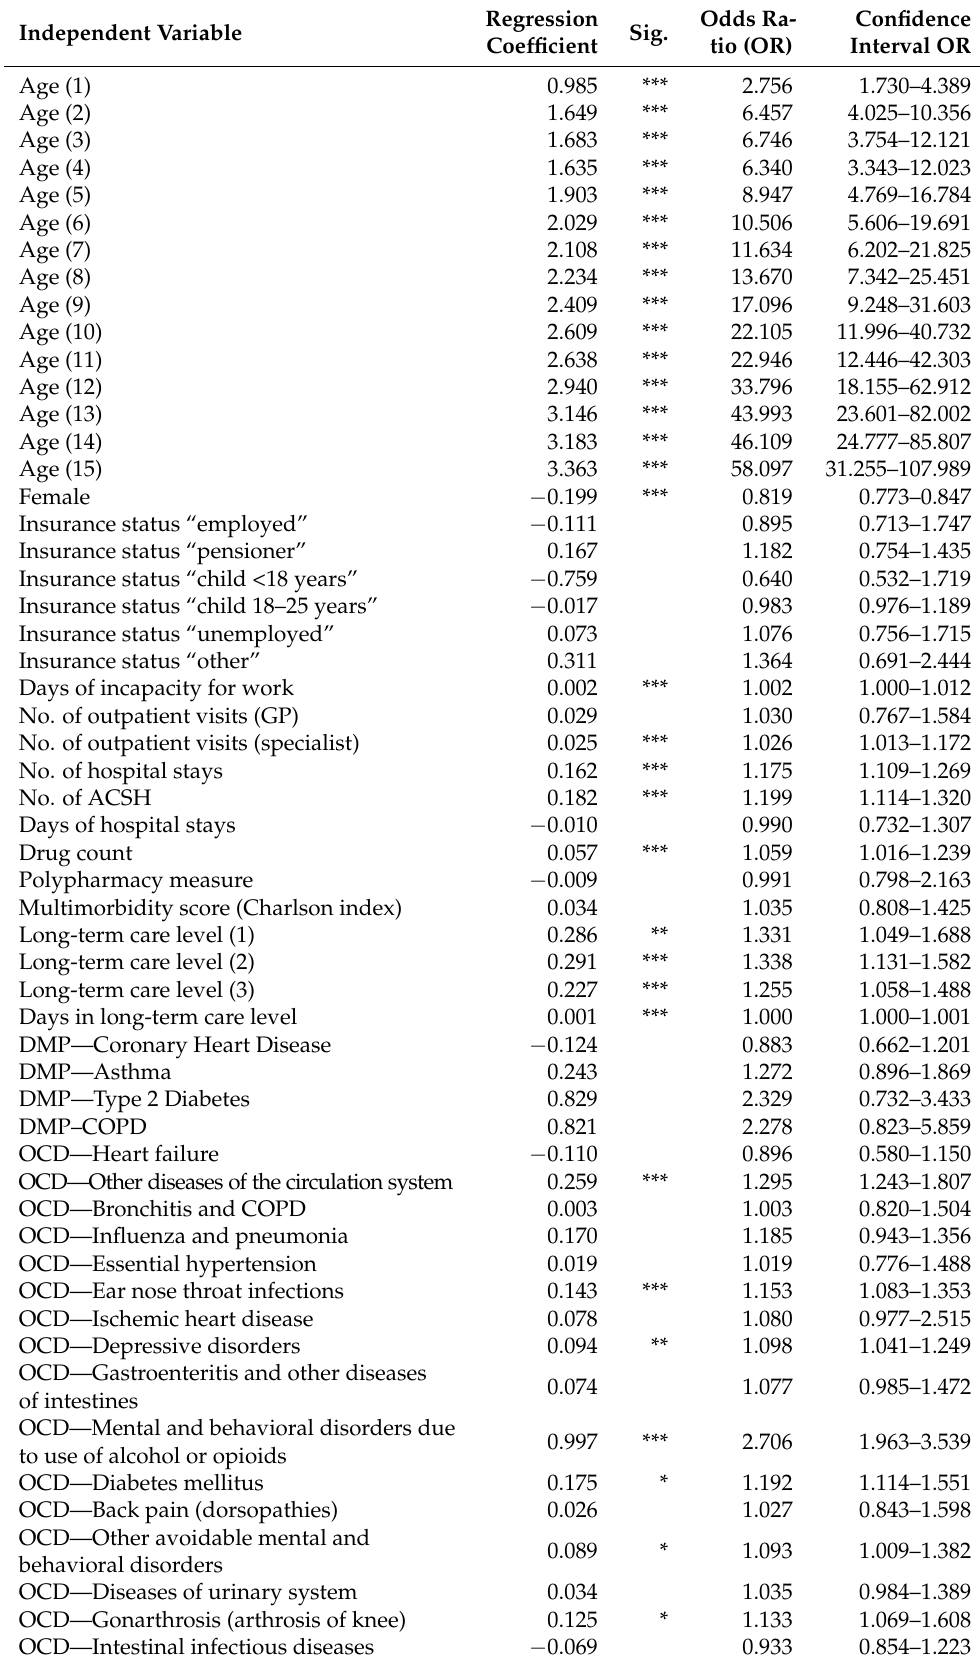
Table A2. Regression coefficients of the independent variables in the logistic regression models for predicting ACSH in the core list